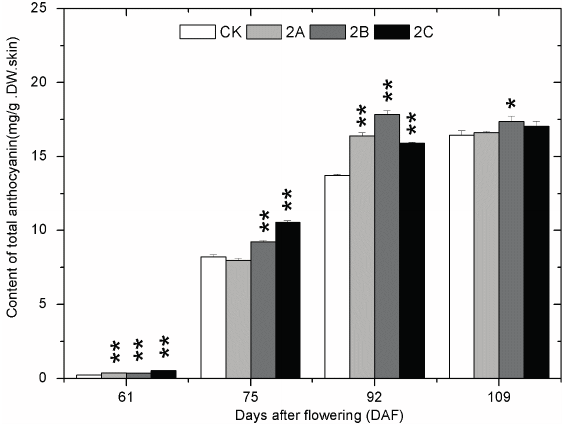
Figure 6. The change of total anthocyanins content in grape skin with developmental stages in the control and Zn-treated groups in 2014. The asterisk represents the content in the